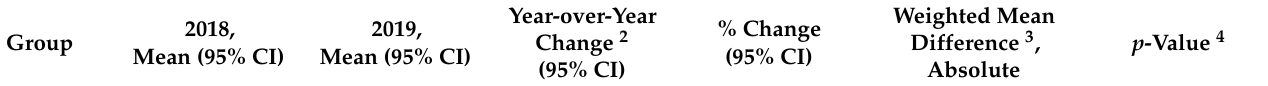
Table 4. Year-over-year changes in medical expenditures adjusted by the actual capitated rate 1